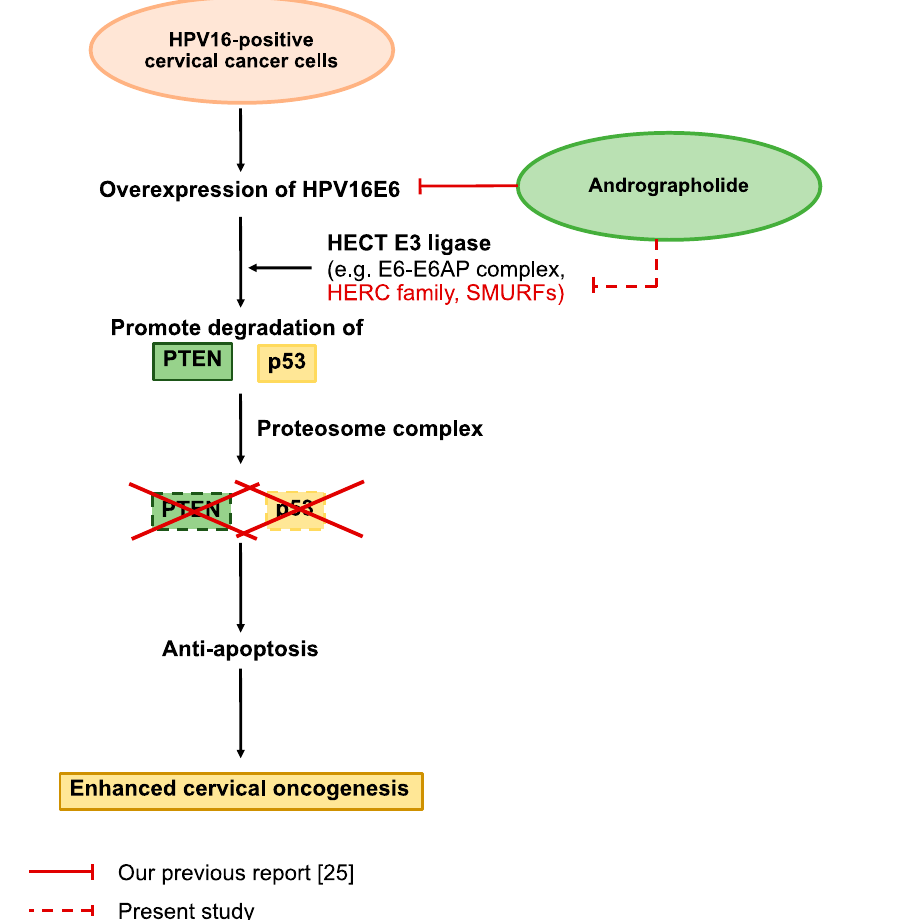
Figure 6. Proposed effects of Androg on inducing apoptosis in HPV16-positive cervical cancer cells. The previous report [25] demonstrated that the expression of E6 was inhibited by Androg in SiHa and CaSki cell lines, leading to programmed cell death in these cell lines. Based on the proteomic profiling of the present study, the apoptosis signaling is also affected by Androg-restored p53 expression via the regulation of UPS-related proteins, including HERC4 and SMURF2.